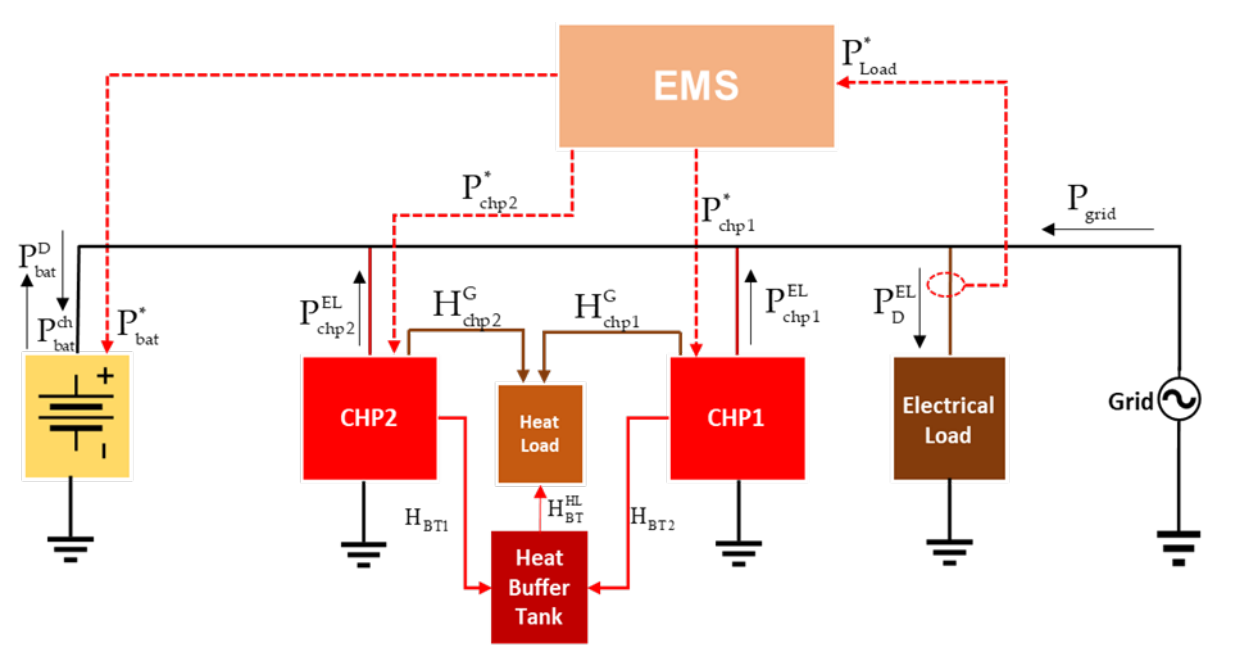
Figure 1. Grid-connected CHP system with energy storage (CHP + BAT + GRID). Up to two-thirds of the energy produced by conventional electricity generation is wasted in heat. The heat recovered from the system can be calculated using Equation (3) representing the relationship between the electrical power generated by the CHP system and the recoverable